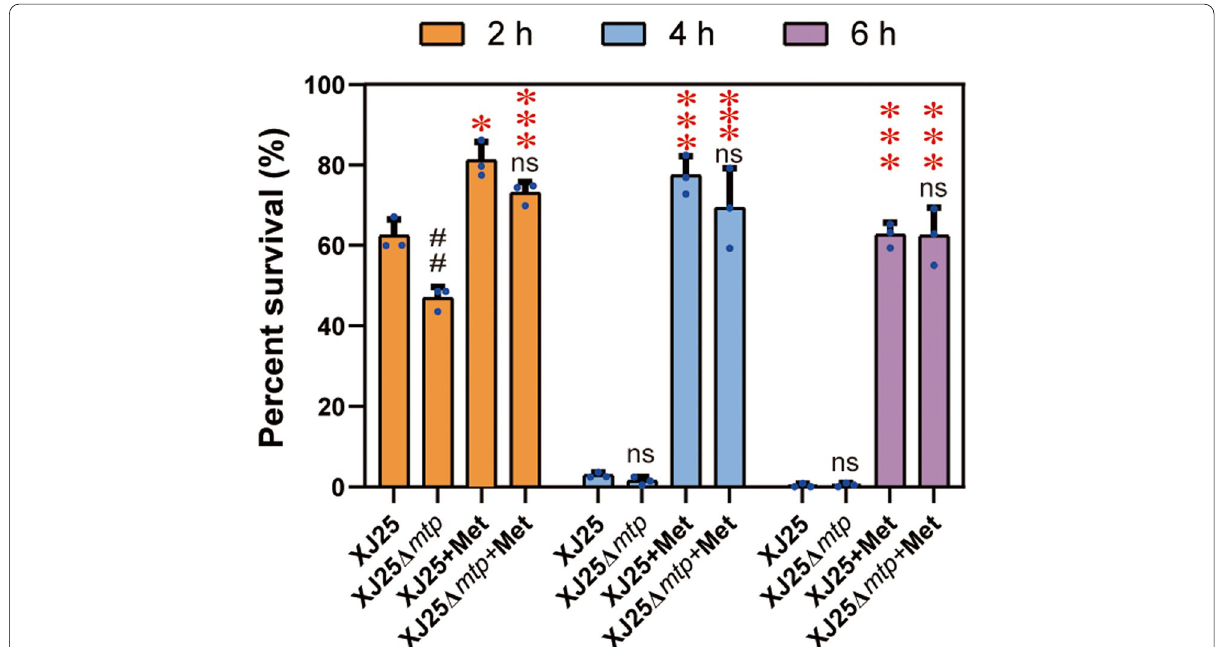
Fig. 1 Effects of acid stress on the survival rates of the wild-type XJ25 and the mutant XJ25Δ mtp cells in CDM. ns, not significant ( p > 0.05), comparison between the wild-type XJ25 and the mutant XJ25Δ mtp (XJ25 vs XJ25Δ mtp , XJ25 Student’s t -test); * p < 0.05, *** p < 0.001, comparison between the stressed cells supplied with and without methionine (XJ25 vs XJ25